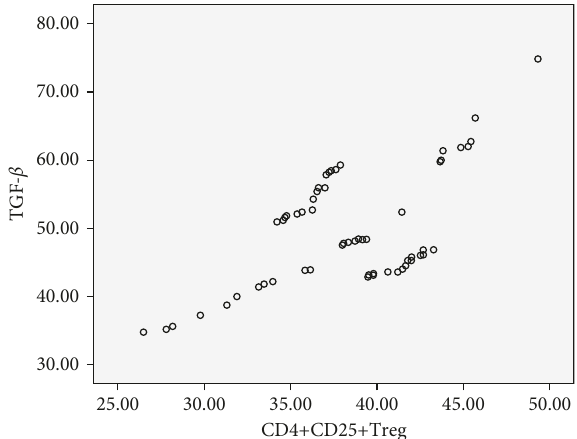
Figure 5: Relationship between CD4 +CD25+Treg and TGF- β